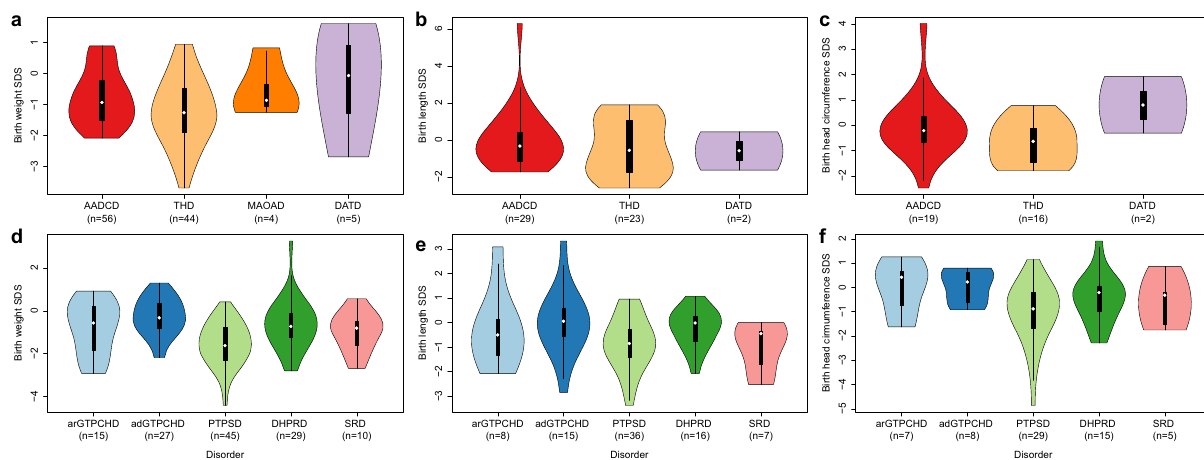
Fig. 1 Birth metrics. Distribution of birth metrics in primary disorders of biogenic amine metabolism ( a – c ) and BH de fi ciencies ( d – f ). White spot: median, black bars: interquartile range (25% and 75%), n: number reported.